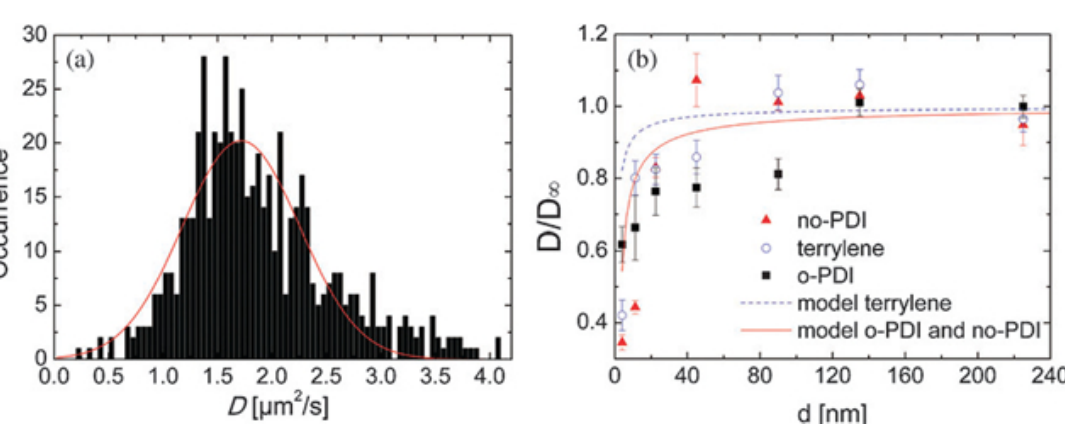
Figure 2. ( a ) Distribution of diffusion coefficients D calculated from trajectories of no-PDI within a 0.2 µm thick 8CB film on 100 nm SiO . The full line shows a Gaussian fit to the 2 distribution; ( b ) Normalized average diffusion coefficients as a function of film thickness d for 8CB on 100 nm SiO together with calculations using a hydrodynamic no-slip 2